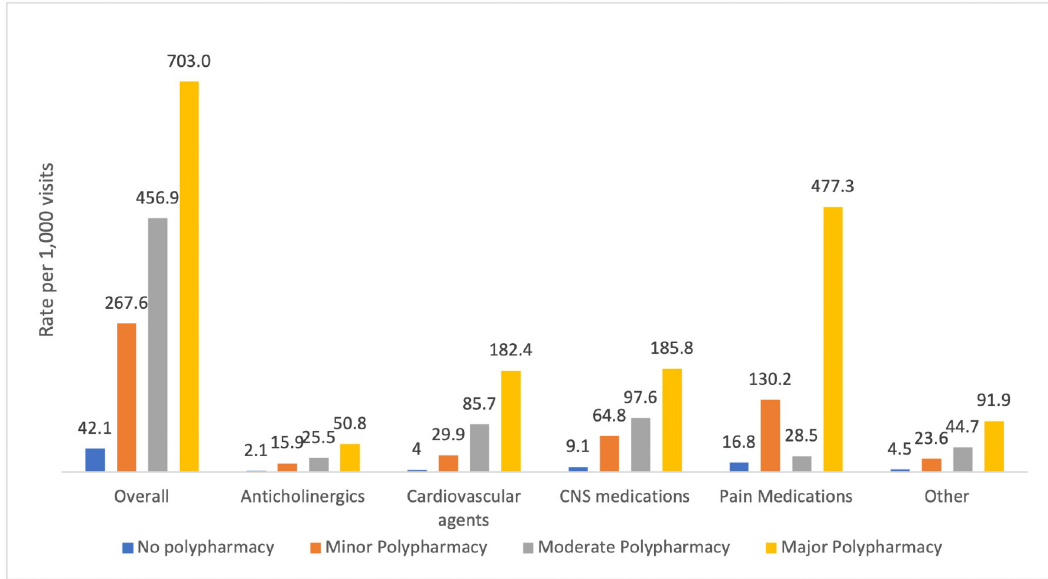
Fig 1. High-risk medication prescription rates by medication category. + All comparisons between no polypharmacy vs. minor polypharmacy vs. moderate polypharmacy vs. major polypharmacy groups were deemed statistically significant (p < 0.0001).